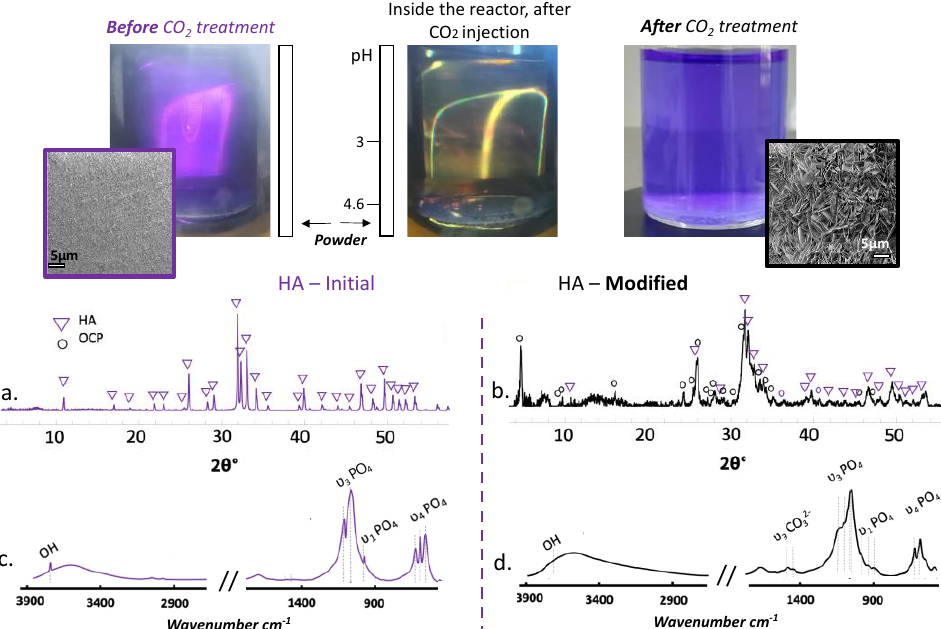
Figure 2. Upper part: Pictures of HA powder immersed in water in the CO 2 reactor in the presence of bromophenol blue, before, during and after CO 2 treatment: color change operates in the pH range 3 (yellow) – 4.6 (purple). Lower part: XRD patterns ( a , b ) and FTIR spectra ( c , d ) on the initial and CO 2 -modified HA powder, respectively.